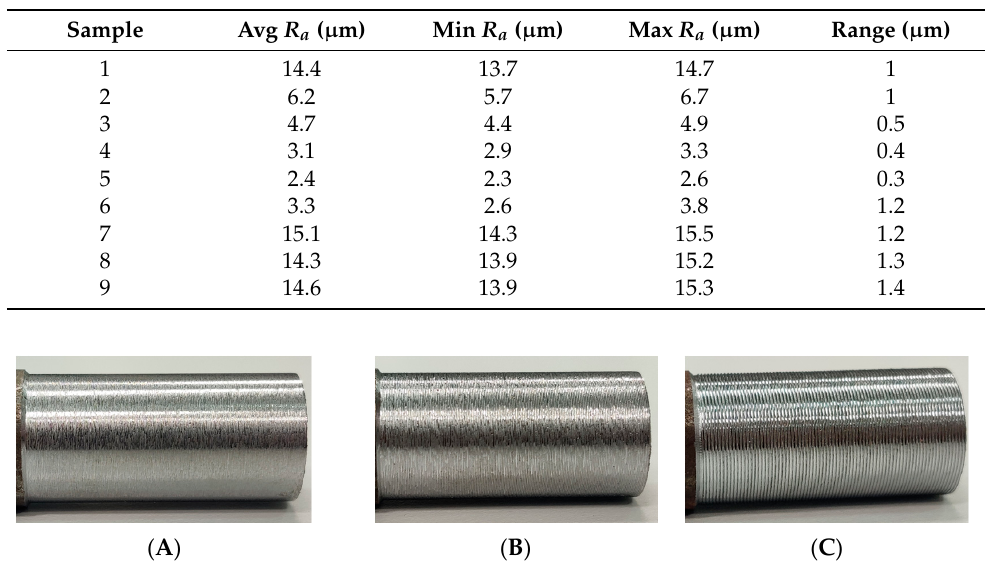
Table 1. Surface roughness range measured with a stylus profilometer.